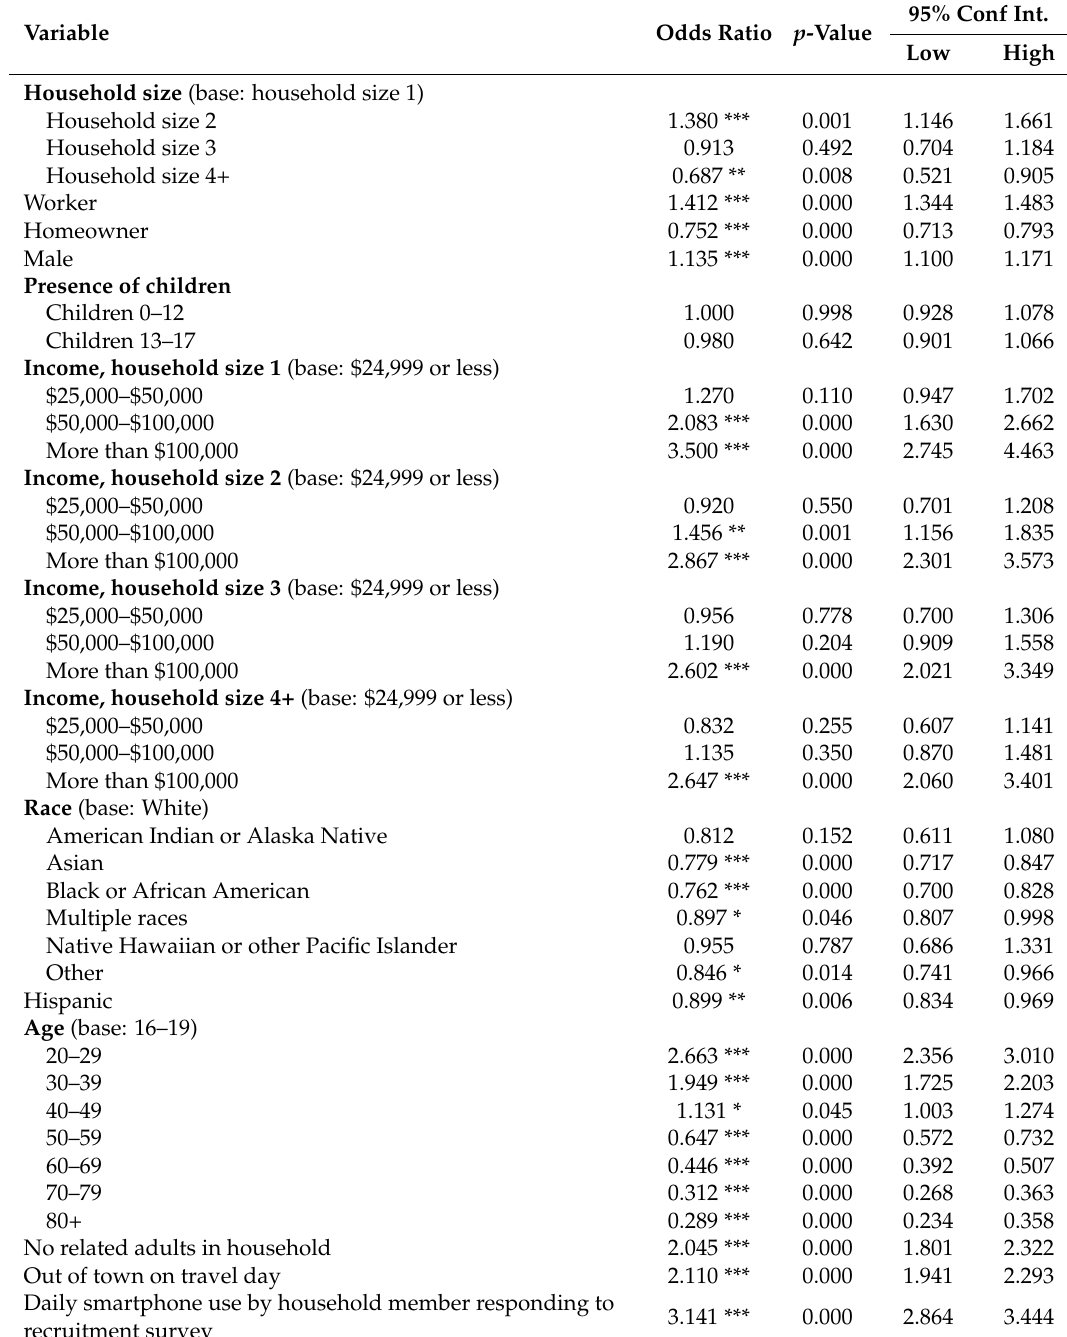
Table 2. Logistic regression